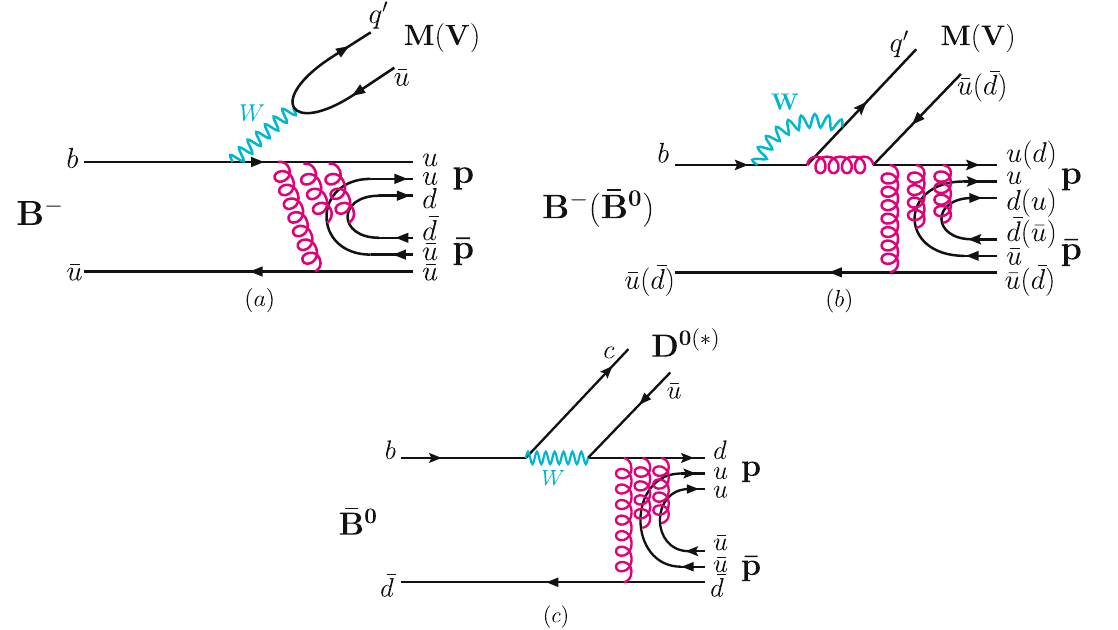
Fig. 2 Feynman diagrams for the three-body baryonic B decays, where ( a , b ) and ( c ) depict B → p ¯ pM ( V ) and ¯ B 0 → p ¯ pD 0 ( ∗ ) , respectively